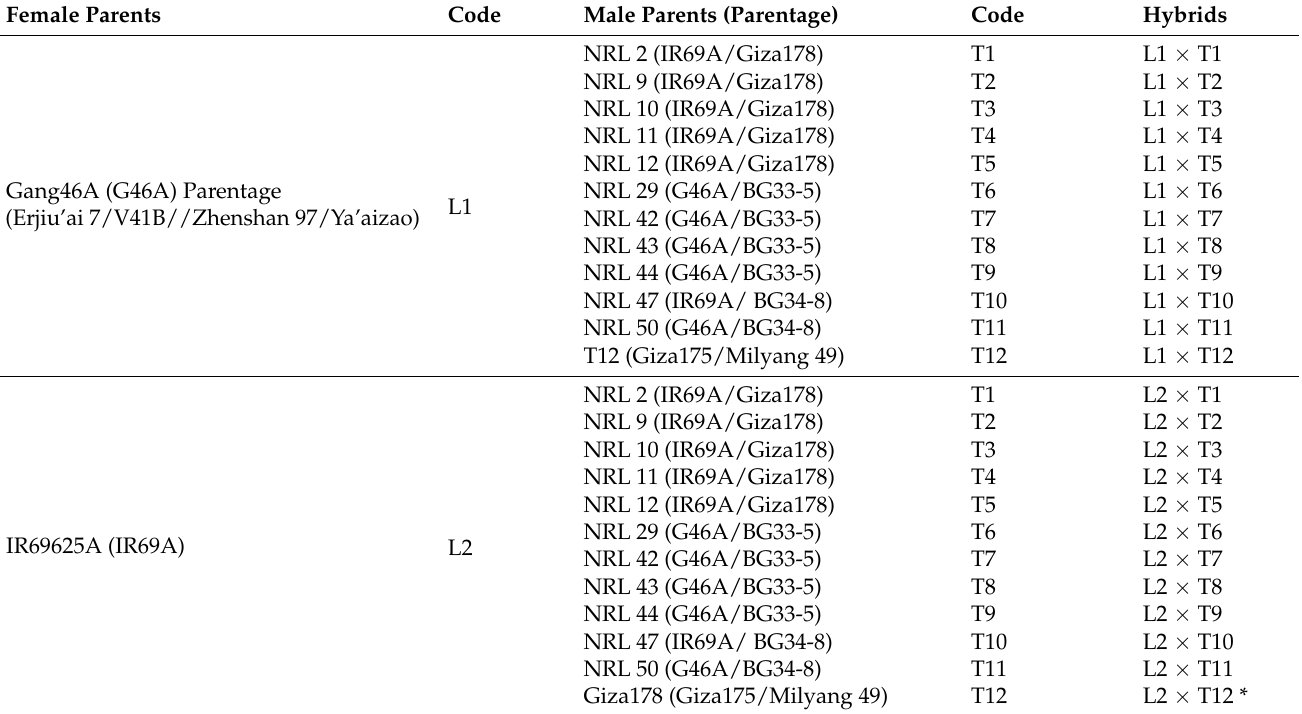
Table 1. Hybrid names, codes, and parentage of the studied